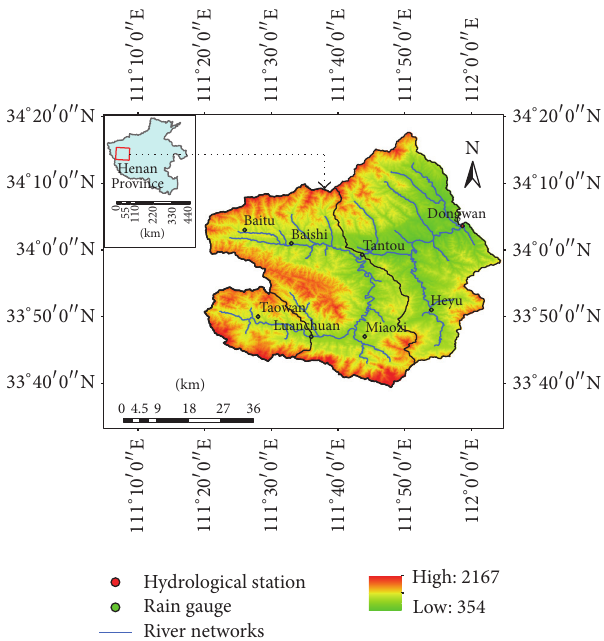
Figure 1: Location, topography, and drainage networks of Dongwan